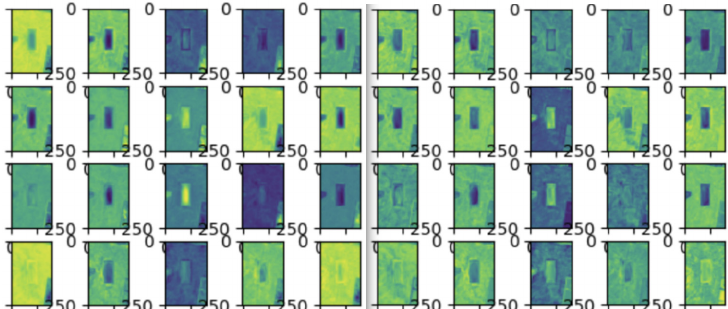
Figure 11. Visualization of attention feature map. Left: channel attention; right: position attention.